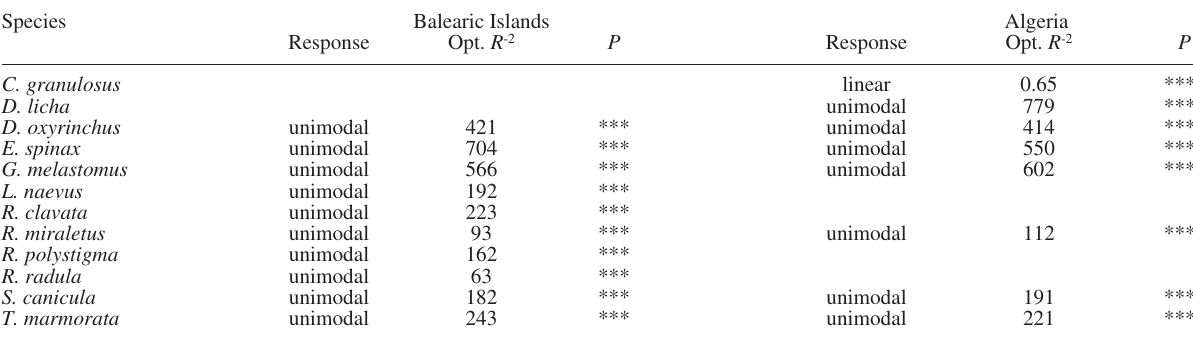
Table 3. – Results of the bathymetric distribution models. Type of the best fitting is indicated. Optimum depth (m) is shown in case of unimodal response; the R 2 is shown for linear responses (Opt. R -2 ). Significance level ( P ) of the regressions is also shown (*** = P <0.001).